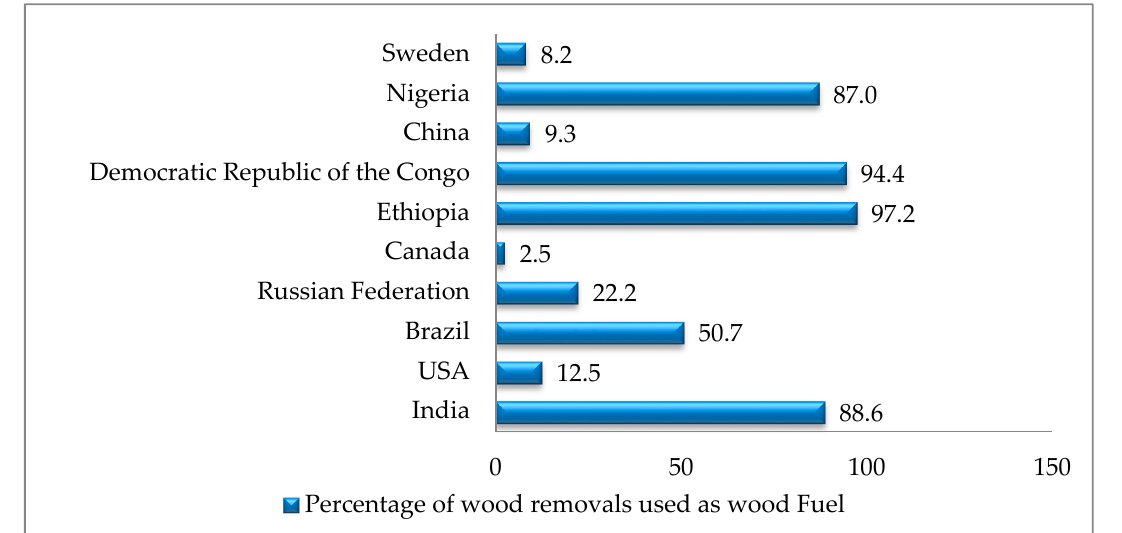
Figure 5. Percentage of Wood used as fuel by top ten, feller of trees worldwide. Data adapted from FAO [49].